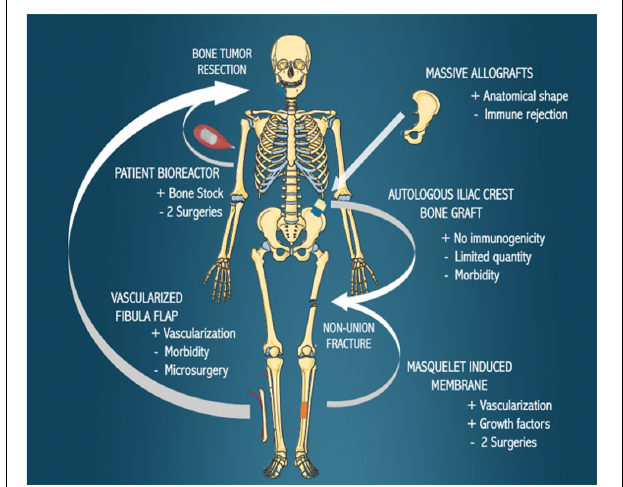
FIGURE 1 | Current biological bone reconstruction techniques. Bone defects arising due to the resection of tumors or non-union fractures can be treated with the various methods indicated, with the benefits ( + ) and disadvantages ( − ) of each technique